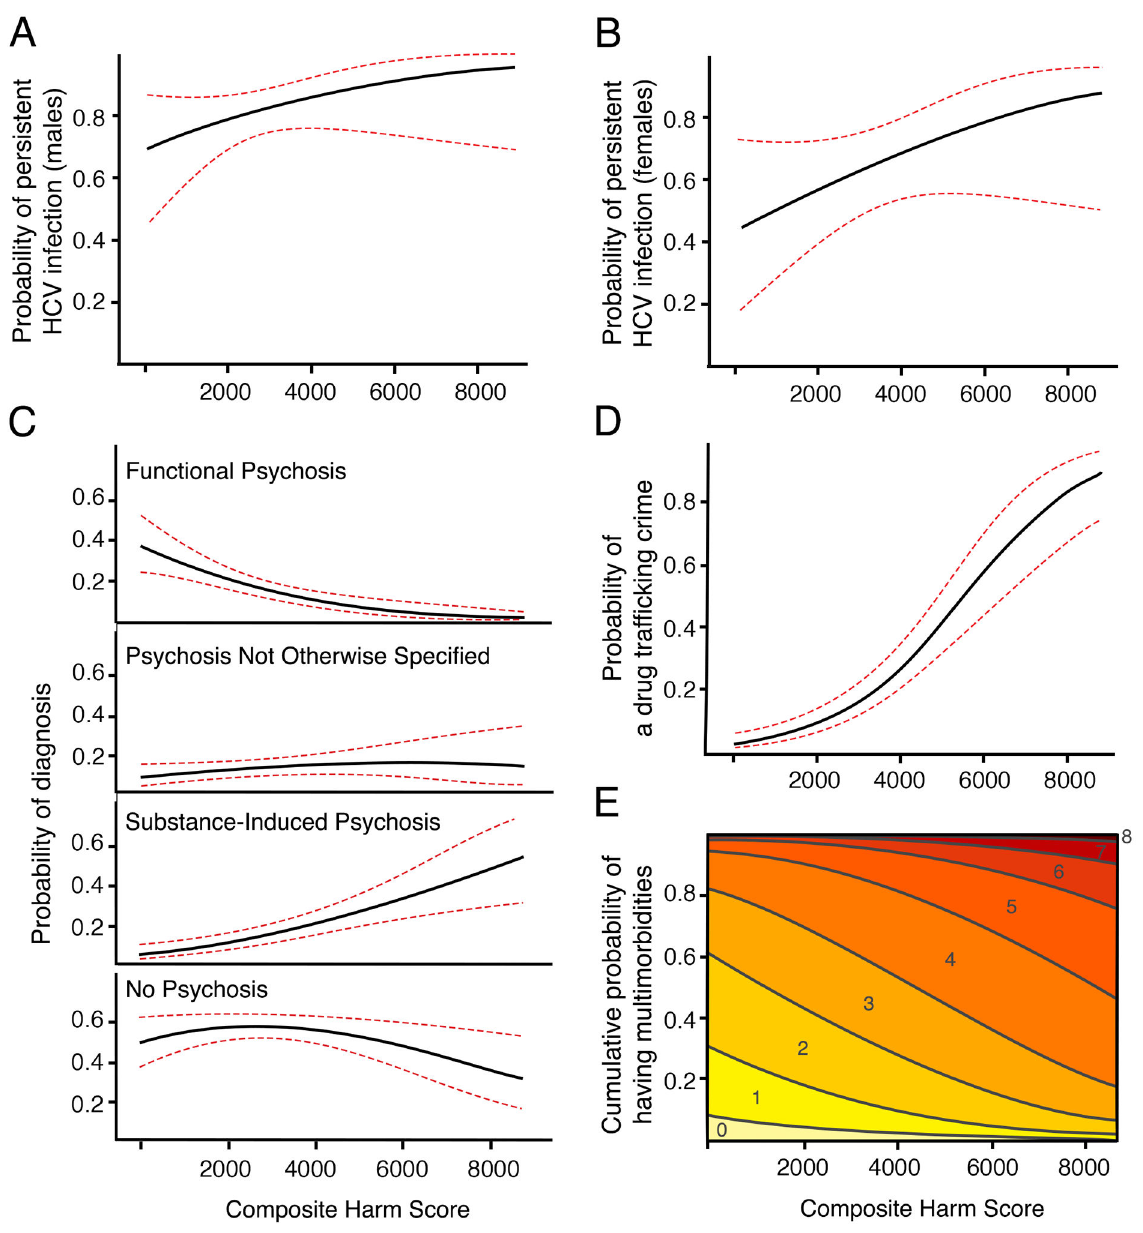
Figure 2. The effect of CHS on the probability of persistent HCV infection, specific psychosis diagnosis, drug trafficking criminal activity, and multimorbidity score. Estimated effect curve (black line) and 95% CI (red, dashed line) are presented for each plot. Panels A and B show the effect display of the influence of CHS on the probability of of persistent HCV infection in males (A) and females (B) adjusting for age. The vertical axis displays the probability of having an active HCV infection at the first serology screen. Panel C shows the effect display of the influence of CHS on psychosis diagnoses, controlling for age and sex. The vertical axis of each display is the probability of substance-induced psychosis, functional psychosis, PNOS, or no psychosis diagnosis, respectively. Panel D shows the effect display of the influence of CHS on the probability of engaging in drug trafficking, adjusting for age and sex. The vertical axis displays the probability of a drug trafficking crime being reported at the baseline assessment. Panel E shows the effect display of the association between CHS and the cumulative probability of having one or more of twelve multimorbid illnesses. Colored bands represent multimorbidity score, ranging from 0-8 in this display.